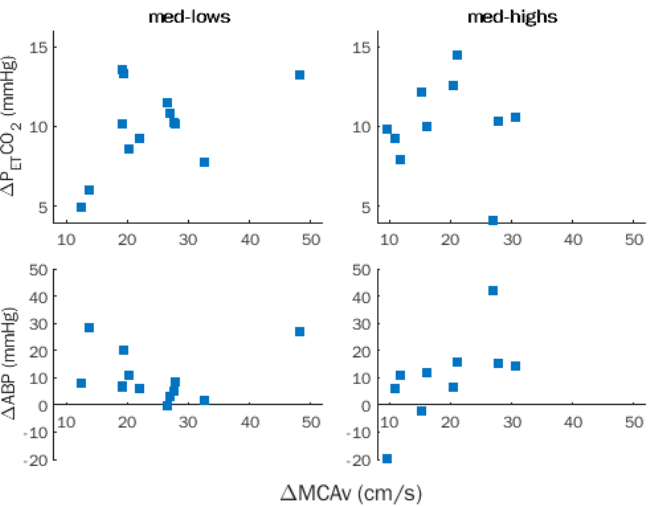
Figure 4. Rebreathing (RBT). Within-group correlations between changes in middle cerebral artery flow velocity (MCAv), partial pressure of end-tidal CO 2 (P ET CO 2 ), and arterial blood pressure (ABP) in med-lows and med-highs.